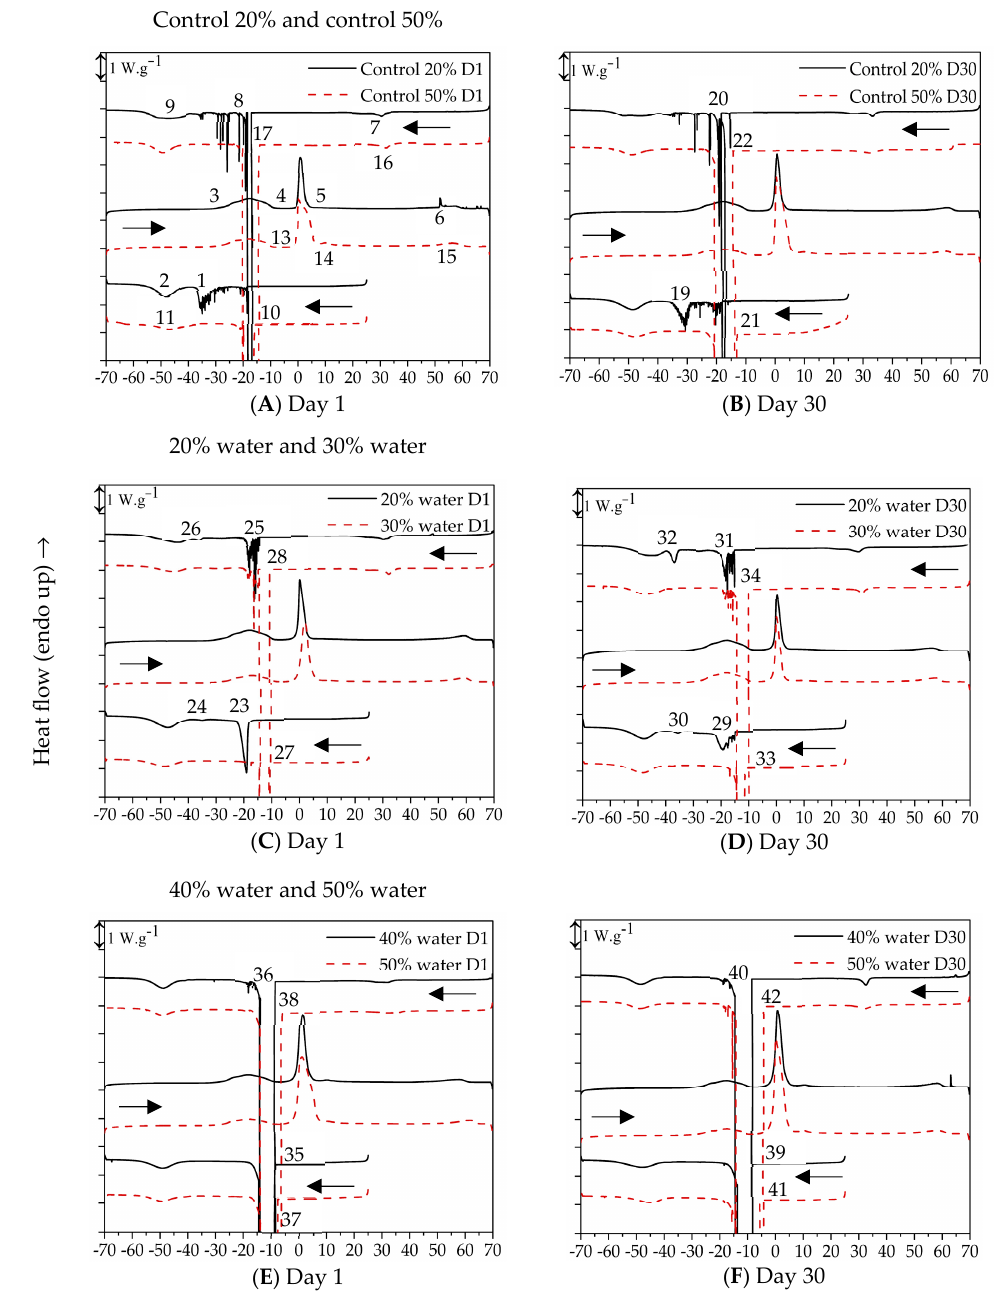
Figure 7. DSC freeze/thaw thermograms of water-in-oil emulsions under aging (on day 1 and day 30) for control emulsions with 20 and 50 wt.% water without LMP ( A , B ) and 20, 30, ( C , D ) 40, and 50 wt.% ( E , F ) water emulsions with LMP. Samples were cooled from 25 °C to − 70 °C, and then heated to 70 °C, followed by a second cooling to − 70 °C, at a rate of 5 °C/min. Arrows indicate the direction of the temperature cycle. Important peaks are identified with numbers and are discussed in the text.